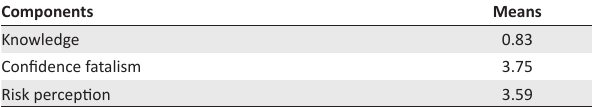
TABLE 3: Means and standard deviation.